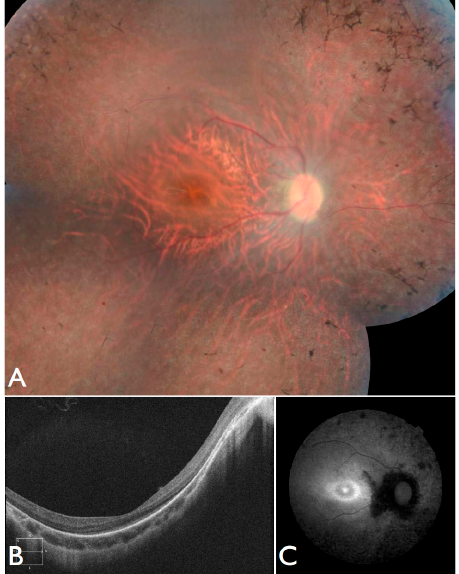
Figure 8. Fundus and OCT images for FBP_53, solved by mutations in INPP5E . ( A ) Color fundus montages showing bilateral pale optic discs, attenuated retinal vessels, normal foveal reflexes, and mild desaturation of the fundus coloration with macular preservation and pigmentary disturbance at the periphery. ( B ) OCT scan and ( C ) Retinal autofluorescence.